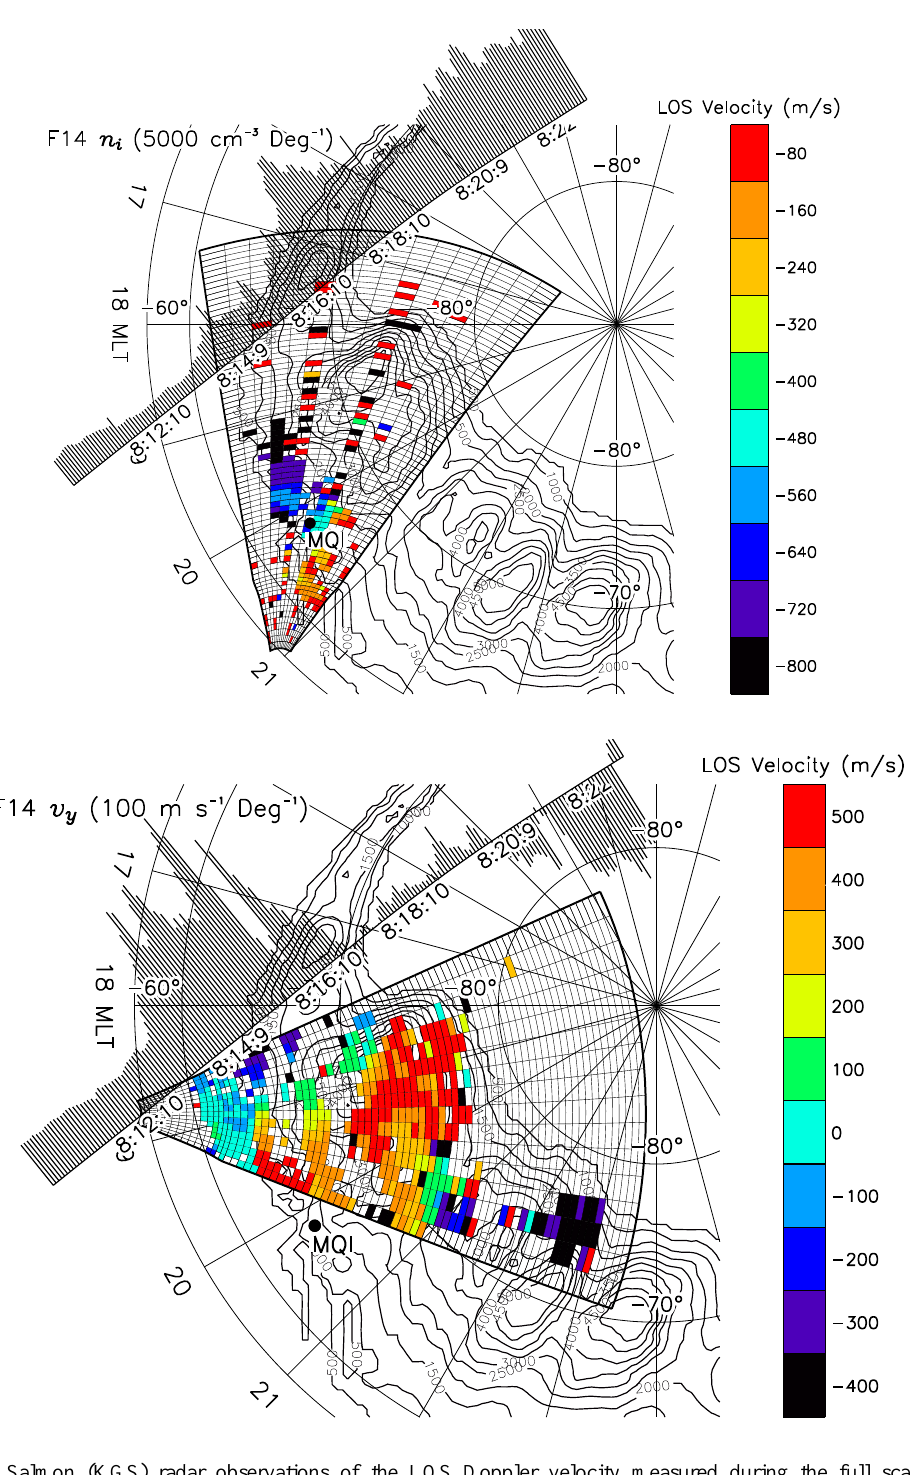
Fig. 4. (a) King Salmon (KGS) radar observations of the LOS Doppler velocity measured during the full scan commencing at 08:15:59 UT on 30 November 2002. The colour key means the colour orange, for example, corresponds to all velocities in the range − 200 <v LOS ≤− 120ms − 1 . DMSP F14 measurements of ion density at 4-s resolution have been superimposed along the satellite trajectory using a transverse scale of 5000 ionscm − 3 per degree of magnetic latitude ( ◦ 3) . (b) TIGER radar observations of the same, except for the full scan commencing at 08:15:00 UT. DMSP F14 measurements of ion drift velocity transverse to the satellite trajectory, V y , have been su- perimposed using a scale of 100ms − 1 ◦ 3 − 1 . The background contours show variations of far ultraviolet (FUV) auroral emissions recorded by the IMAGE WIC experiment at 08:15:54